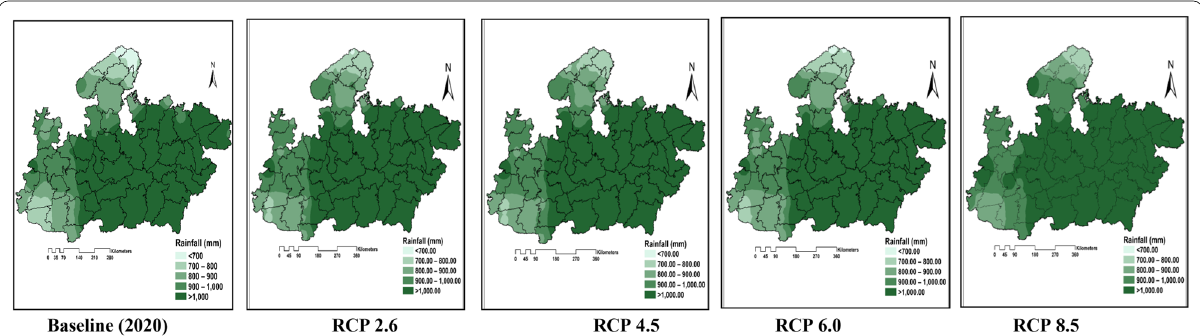
Fig. 5 Predicted change in the precipitation relative to baseline over the whole Madhya Pradesh state under different RCP scenarios of 2050